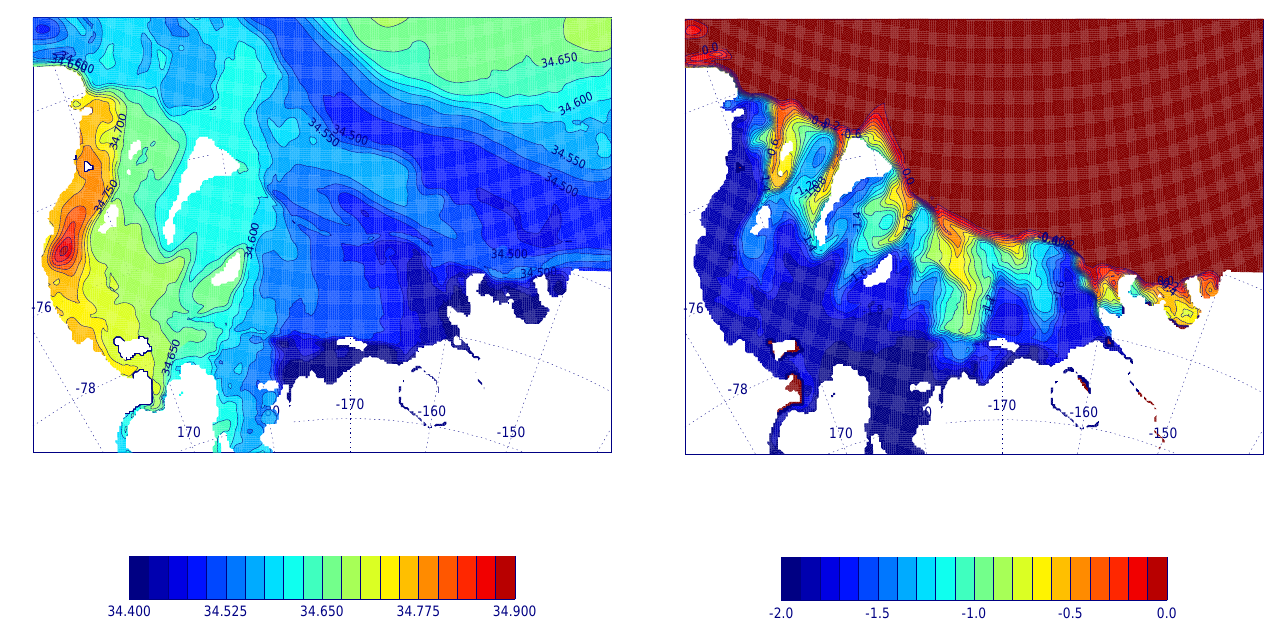
Fig. 5. Annual mean temperature at 300m from the simulation model. White areas in the figure are either land or areas that are shallower than